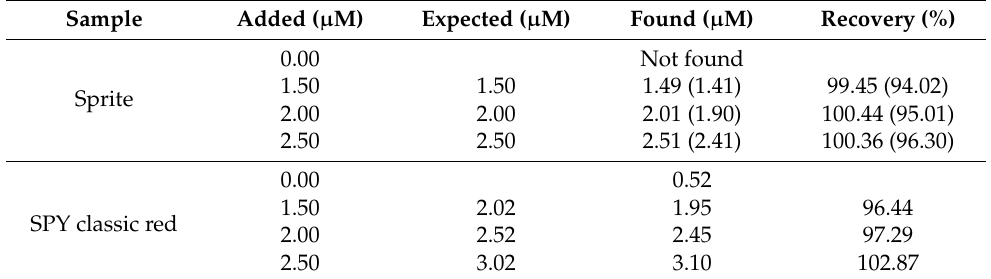
Table 5. Performance of modified sensor for amaranth determination in real sample.